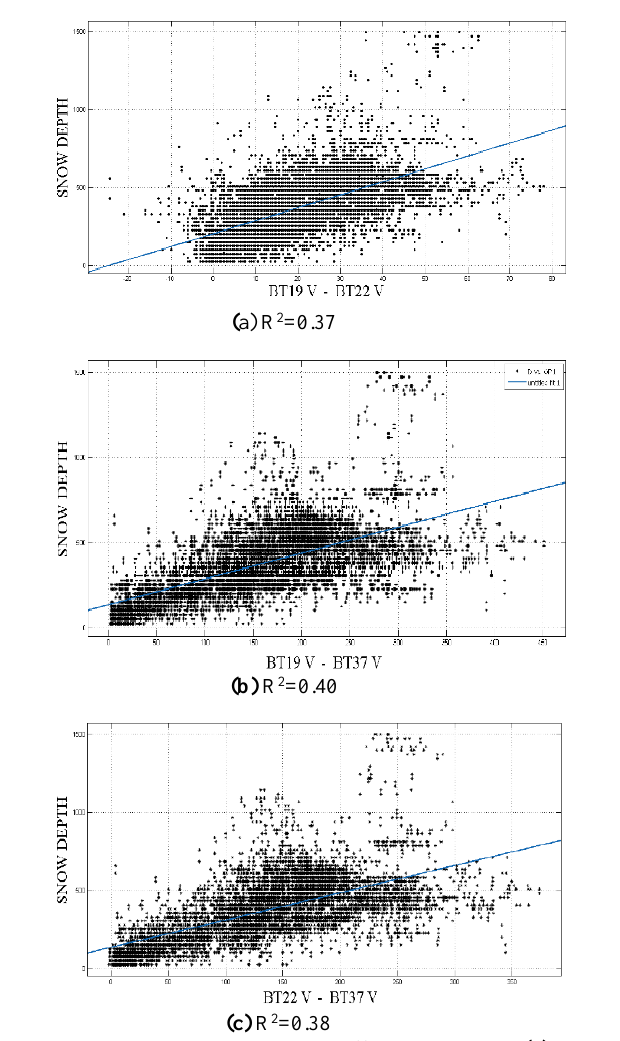
Figure 5. Brightness temperature difference between (a) B19-B22 and SD, (b) B19-B37 and SD and (c) B22-B37 and